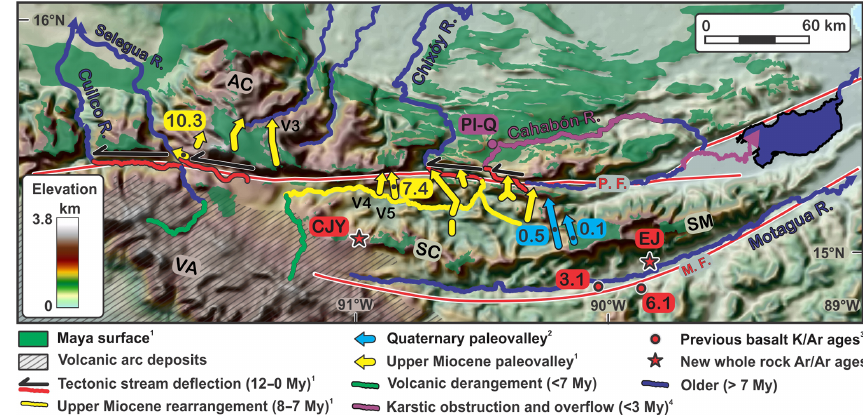
Figure 2. Age of geomorphic markers and drainage lines in central Guatemala. Ages of Miocene valleys and Quaternary paleovalleys (V1– V12) in Myr. Data source are as follows: 1: Brocard et al. (2011); 2: Brocard et al. (2012); 3: Tobisch (1986); 4: Plio-Quaternary lacustrine deposits (Brocard et al., 2015a). Newly dated lavas are defined as follows: CJY: Chujuyúb; EJ: El Jute. Range names are defined as follows: AC: Altos de Cuchumatanes; SC: Sierra de Chuacús; SM: Sierra de las Minas; VA: volcanic arc. Faults are defined as follows: MF: Motagua; PF: Polochic. The background used is taken from the shaded GTOPO 30 DEM.